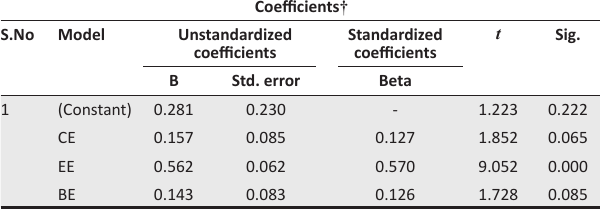
TABLE 3c: Multiple regression